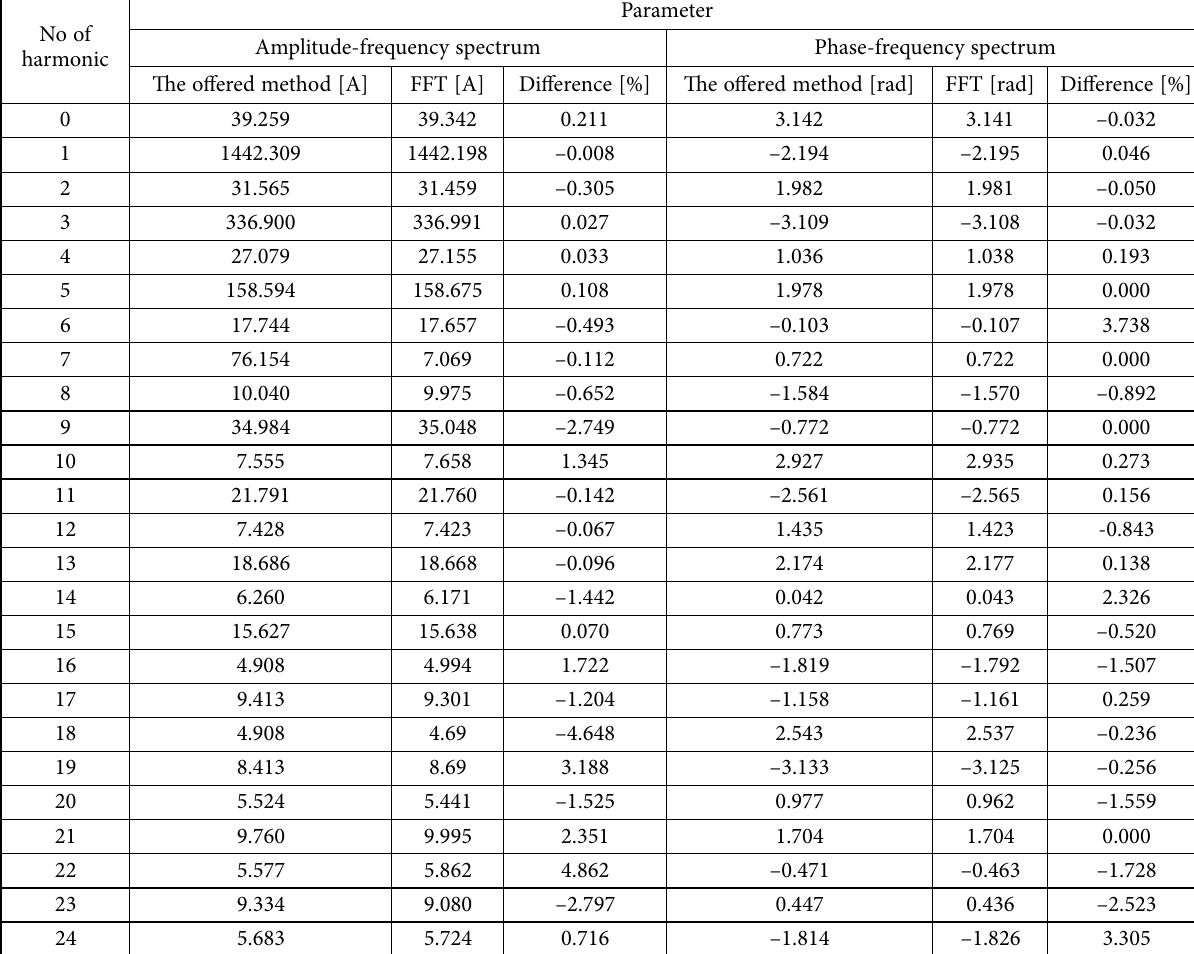
Table. Comparison of computation results gained by developed method and the FFT No of